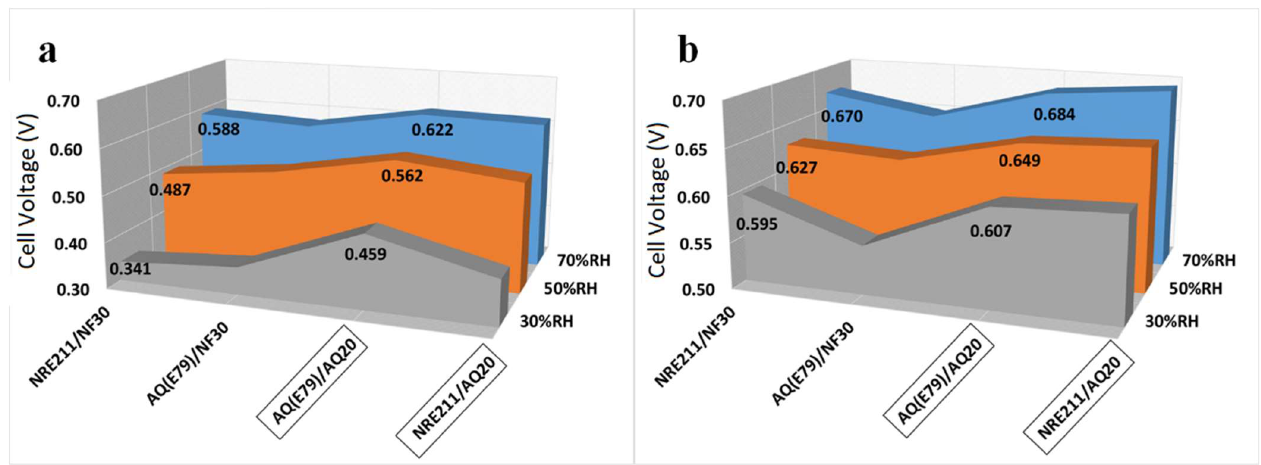
Figure 6. ( a ) Cell voltage without iR correction; ( b ) cell voltage with iR correction at a current density of 1.0 A cm −2 at 80 °C and various RH.